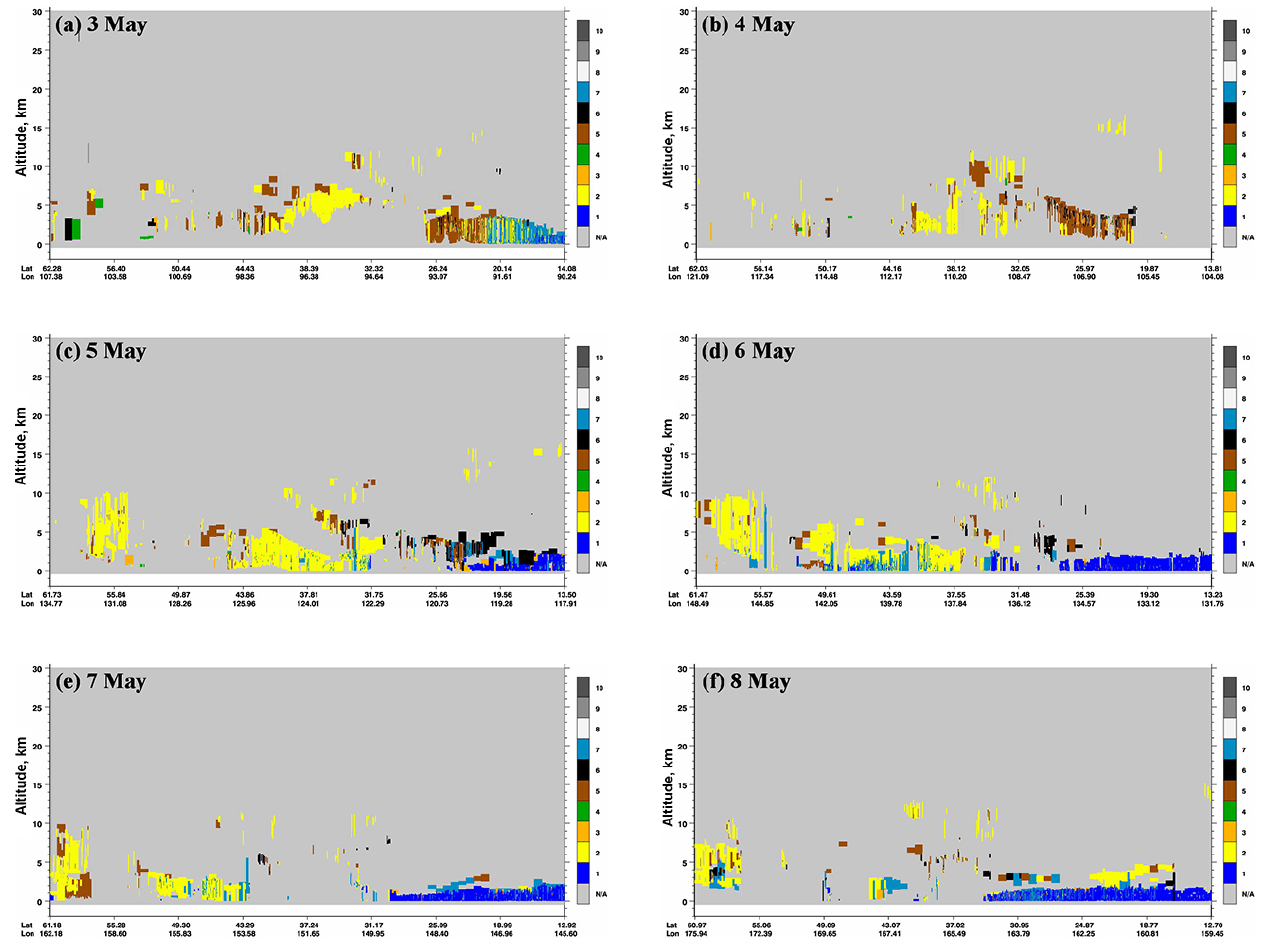
Figure 4. (a) – (f) CALIPSO aerosol subtypes on 3–8 May 2017, corresponding to the overpass trajectories shown in Fig. 2. The dust aerosol is shown in yellow. The 10 aerosol subtypes are 1, marine, 2, dust, 3, polluted continental/smoke, 4, clean continental, 5, polluted dust, 6, elevated smoke, 7, dusty marine, 8, polar stratospheric cloud (PSC) aerosol, 9, volcanic ash, and 10,